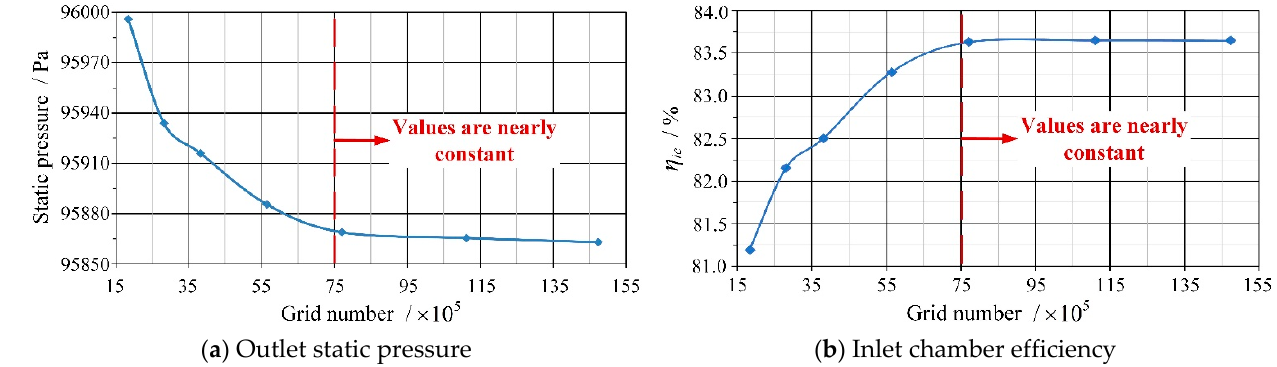
Figure 3. Variations of the flow and performance parameters with the grid number.